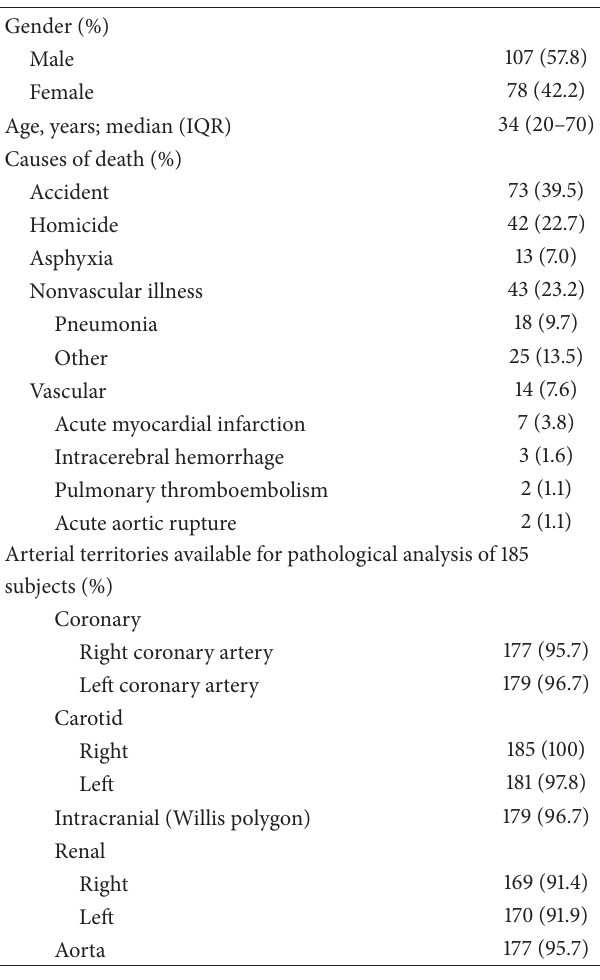
Table 1: Demographic data, death causes, and distribution of arterial territories available for pathological analysis of the 185